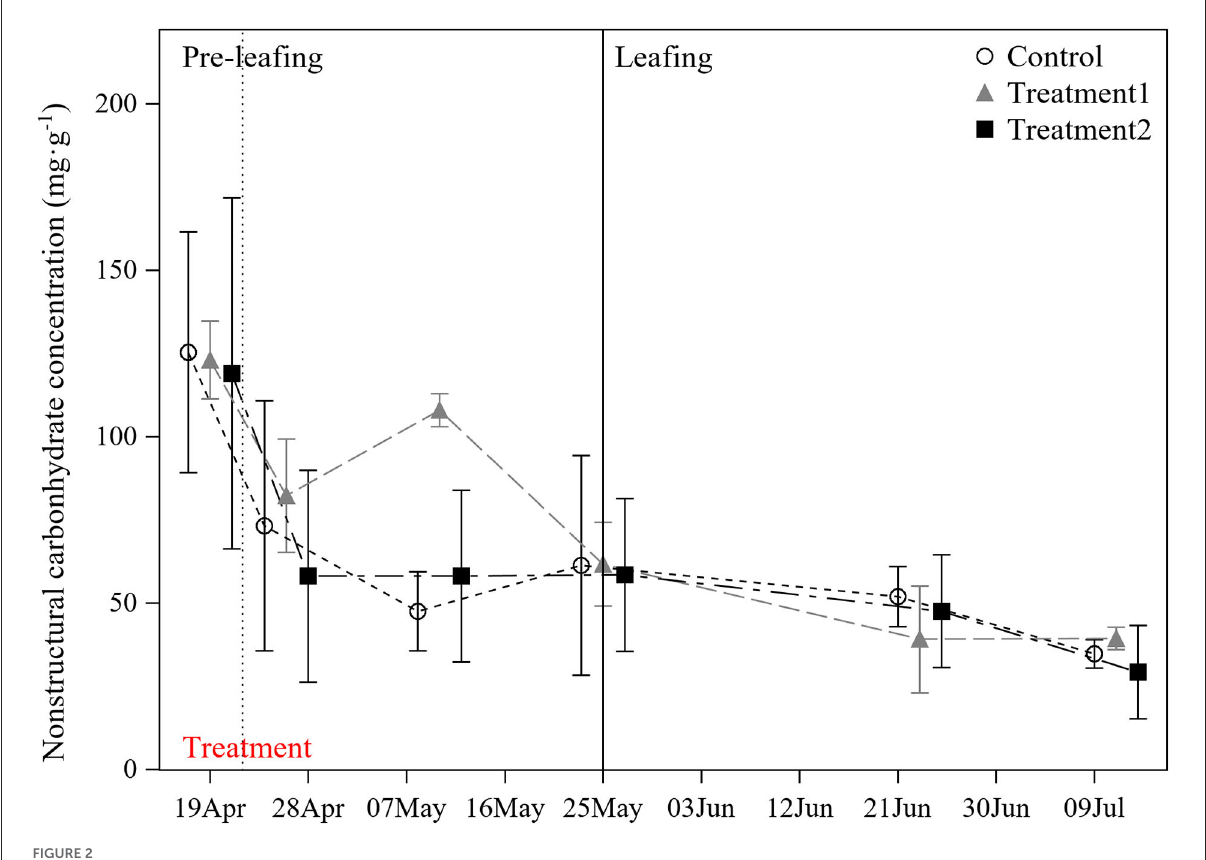
FIGURE2 Dynamics of non-structural carbohydrates in stems of mother culms over the experimental period.